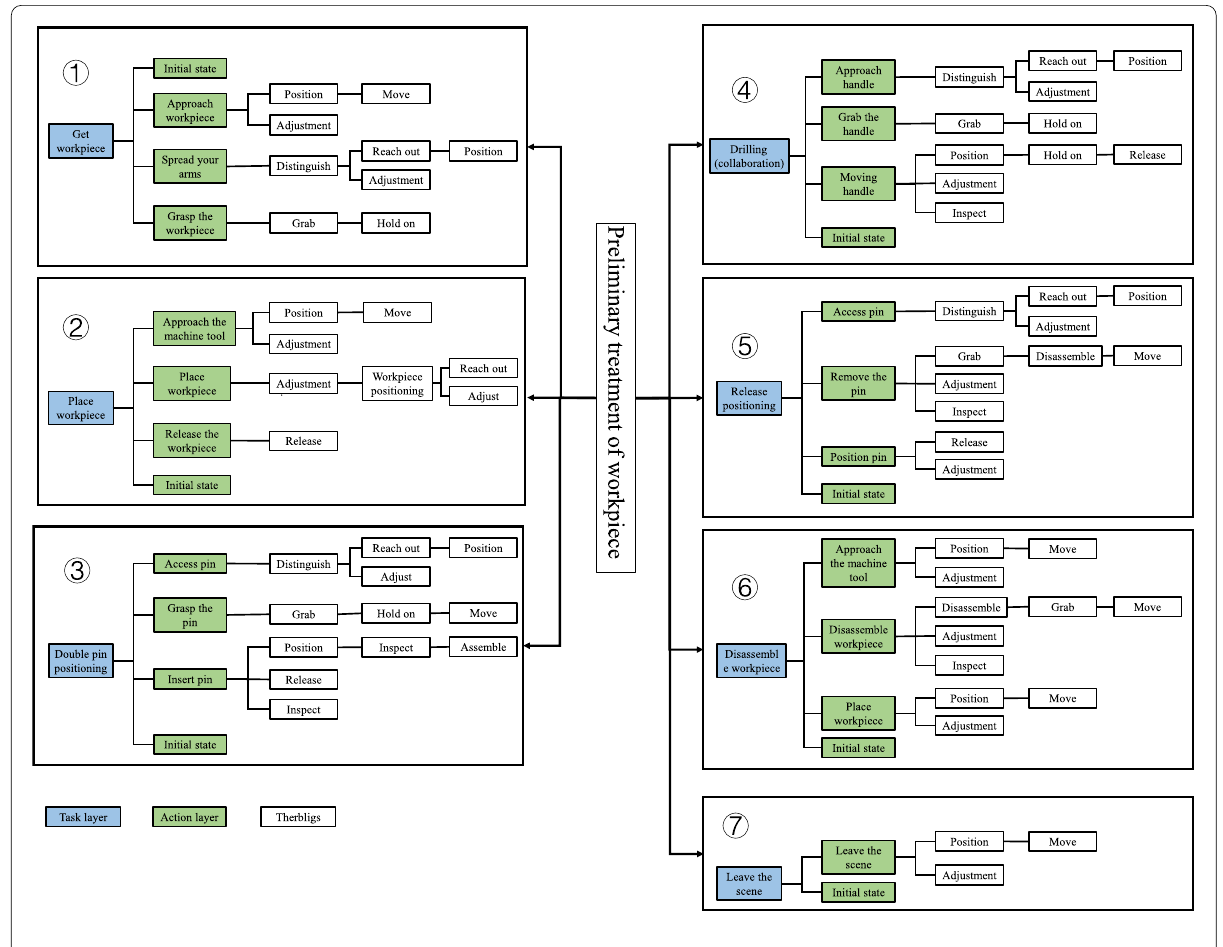
Figure 7 Partial actions involved in workpieces operation